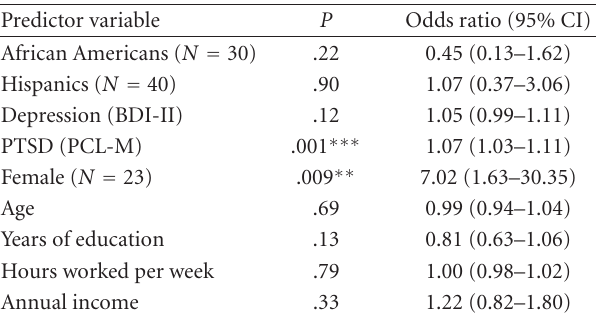
Table 4: Logistic regression predicting individual and group